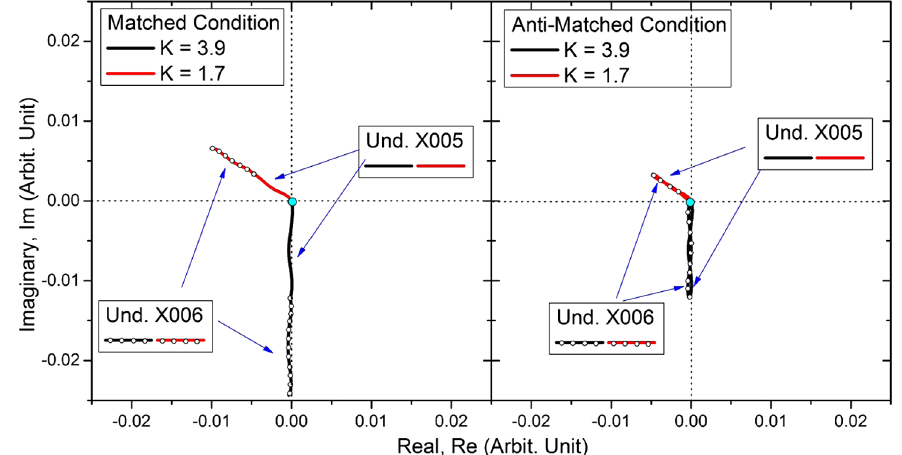
FIG. 7. Hodograph of the real and imaginary part of the radiation A with 2 n π phase difference. The right plot corresponds antimatched phasing with ð 2 n þ 1 Þ π phase difference leading to zero amplitude in the forward direction.